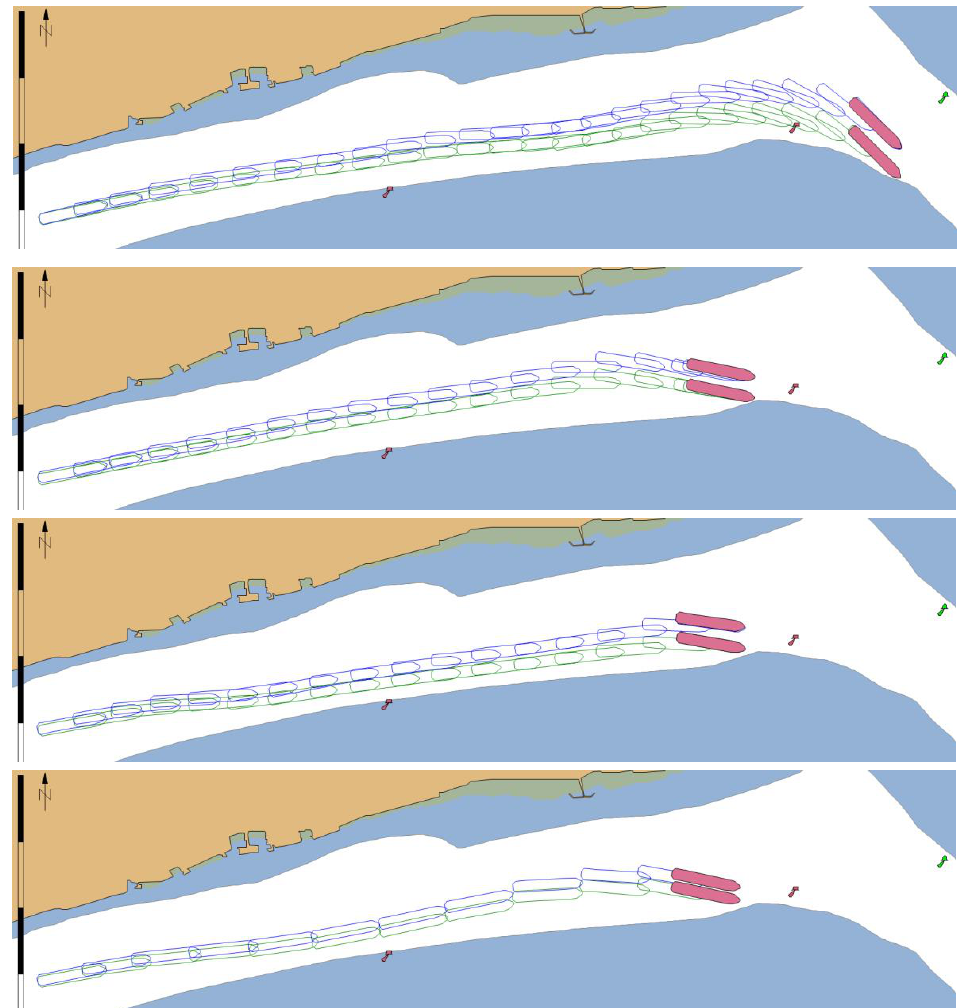
Figure 16. Example of 4 passages of the MASS with simulated GNSS signal deterioration – without integrity data presentation in ECDIS.